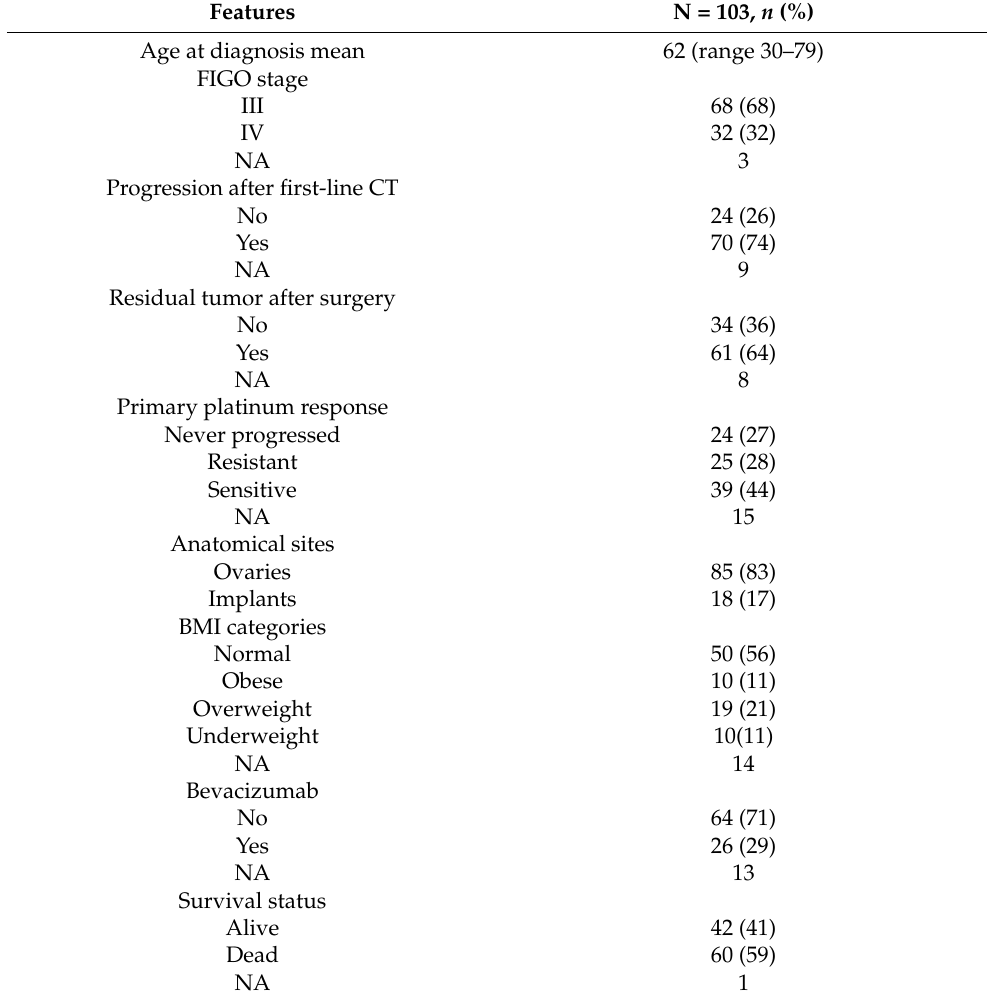
Table 1. Clinicopathologic features of the